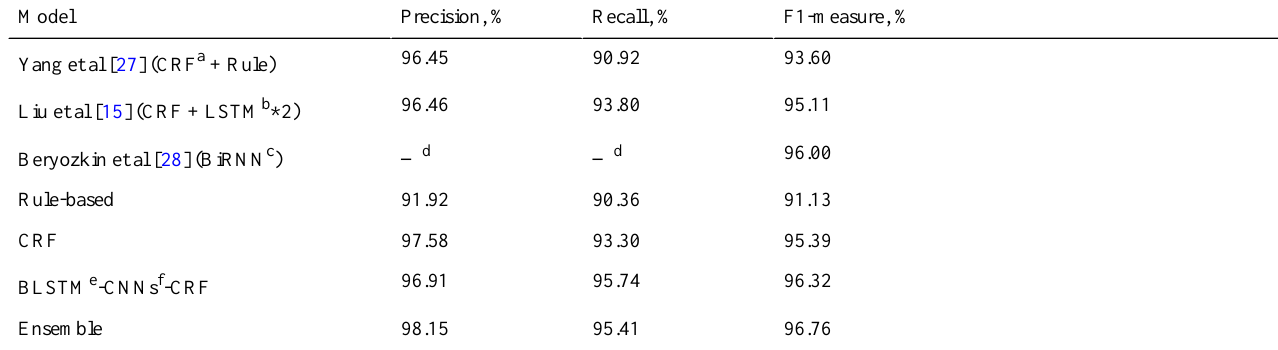
Table 4. Results of the hybrid system and submodels (i2b2 categories, strict entity matching).